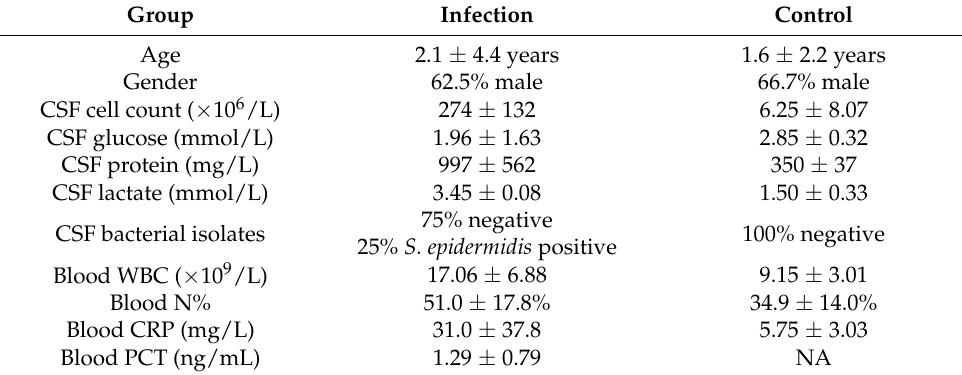
Table 1. Patient